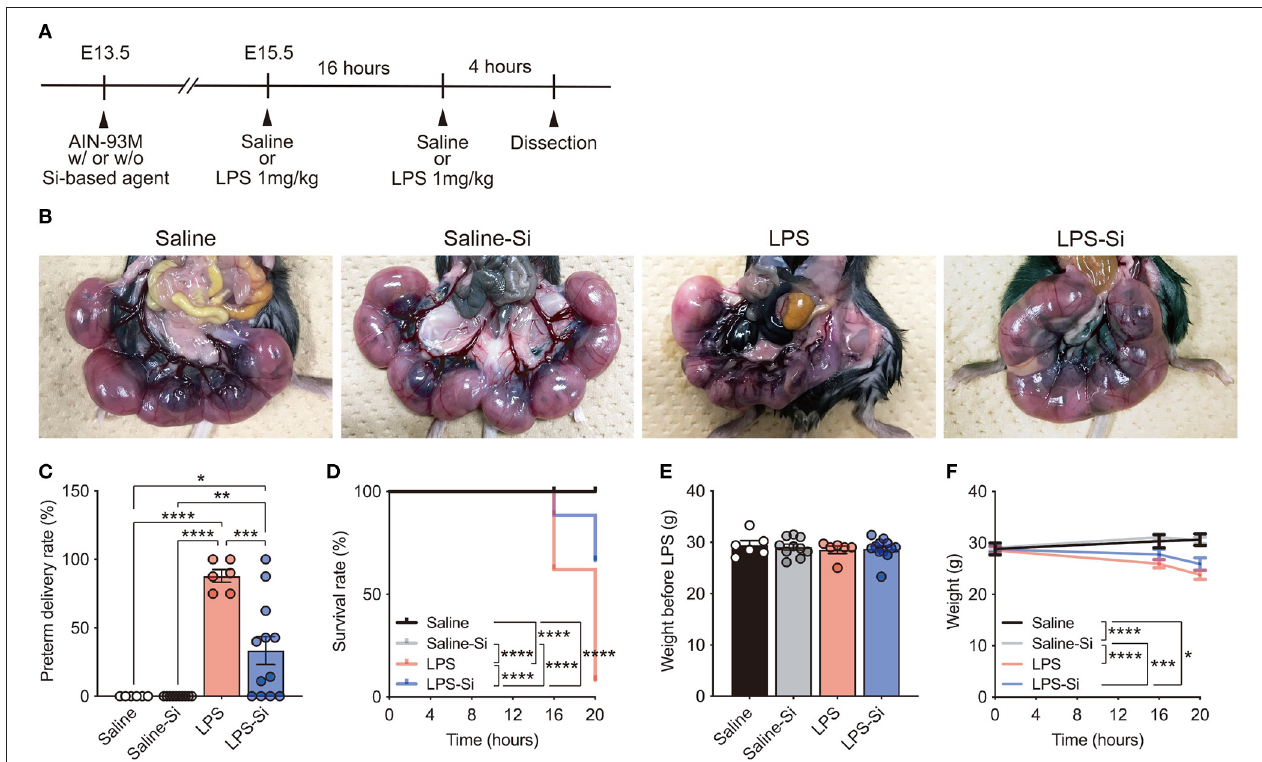
FIGURE 1 | Silicon-based agent protects against miscarriage. (A) Experimental scheme. Pregnant mice were fed the AIN-93M diet with or without 2.5 weight % Si-based agent from E13.5 until dissection. Saline or lipopolysaccharide (LPS) (1 mg/kg) was intraperitoneally injected into pregnant mice at E15.5 and 16h after the first administration. Quantification was performed at 16 and 20h after the first administration. Pregnant mice were dissected at 4h after the second administration. (B) Representative image showing the mouse uterus and fetus. The Si-based agent protects the fetus from LPS-induced miscarriage. (C) Preterm delivery rates (%) per litter for pregnant mice at 20h after administration. (D) Survival rates (%) at 16 and 20h after administration. The Si-based agent significantly improved the survival rate of fetuses. (E) Weight of pregnant mice before LPS-treatment. (F) Weight loss in LPS-treated pregnant mice at 16 and 20h. Data are presented as means ( ± SEM). **** P < 0.0001, *** P < 0.001, ** P < 0.01, * P < 0.05, two-way ANOVA or Log-rank (Mantel-Cox) test. The numbers of pregnant mice used for analyses of weight and preterm delivery rates were as follows: saline, n = 5; saline-Si, n = 10; LPS, n = 6; and LPS-Si, n = 12. The numbers of embryos used for survival rate analyses